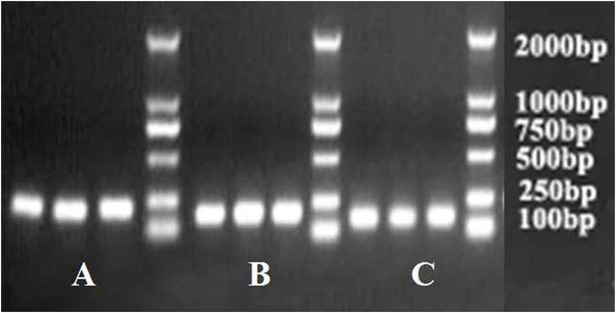
The electropherogram of RT-PCR product of GAPDH(A), TGF-β1(B), and HIF-1α (C).